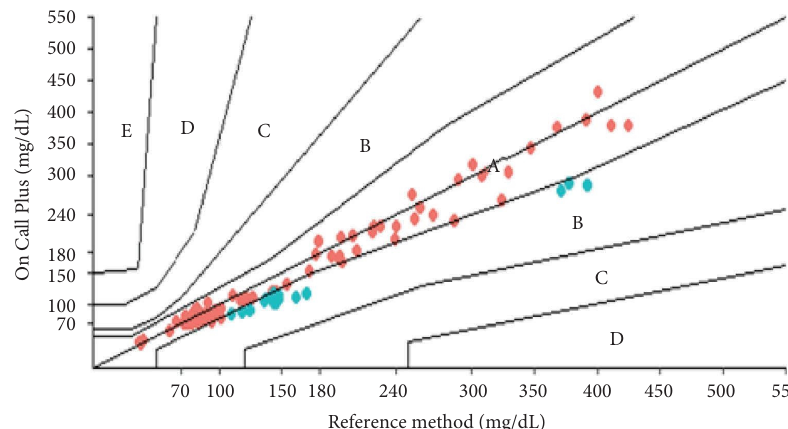
Figure 8: Error grid for the On Call plus ®